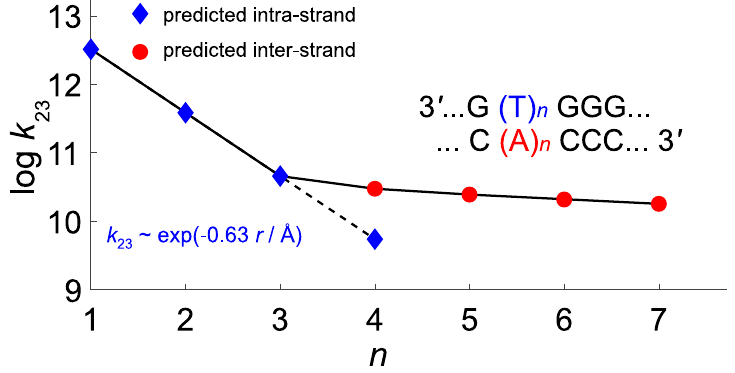
Figure 11. Predicted rate constants k 23 for the HT step in 3 (cid:48) -G(T) n GGG-5 (cid:48) DNA sequences, as a function of the number of bases separating the donor (G) and the acceptor (GGG) sites; blue diamonds, Intrastrand; red circles, Interstrand HT via the (A) n bridge of the complementary helix. The predicted parameter of the Marcus–Levich–Jortner equation (in blue) for the short distance regime ( n = 1–3) is in excellent agreement with its experimental counterpart. For n ≥ 4, HT is predicted to occur interstrand, mediated by the adenine bridge. Adapted with permission from J. Phys. Chem. Lett. 2019 , 10 , 1845–1851. Copyright (2019) American Chemical